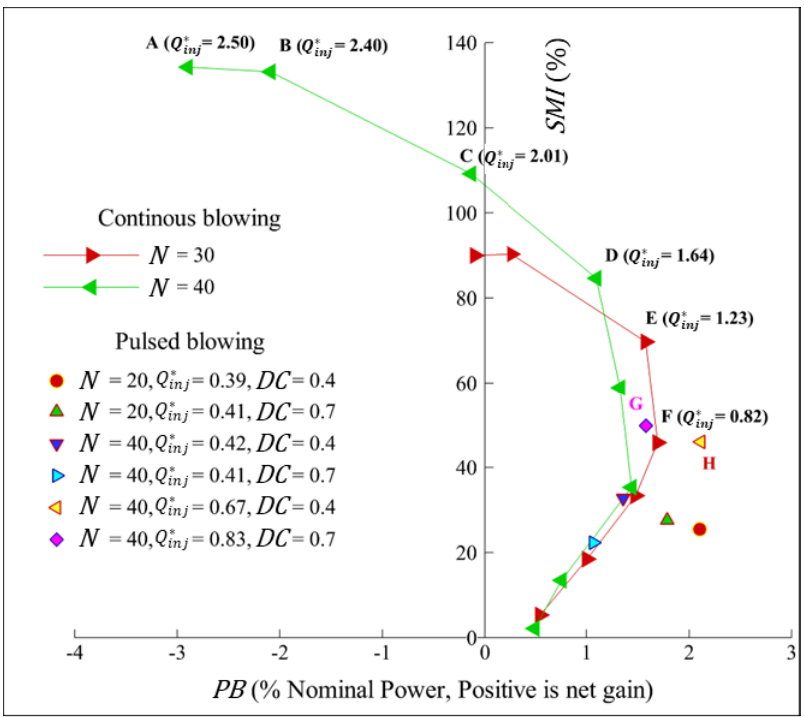
Figure 13. SMI and power balance in pulsed and continuous blowing with the absolute injection angle 𝛼 𝑗𝑒𝑡 = −30° and the rotation speed 𝛺 = 3200 rpm.